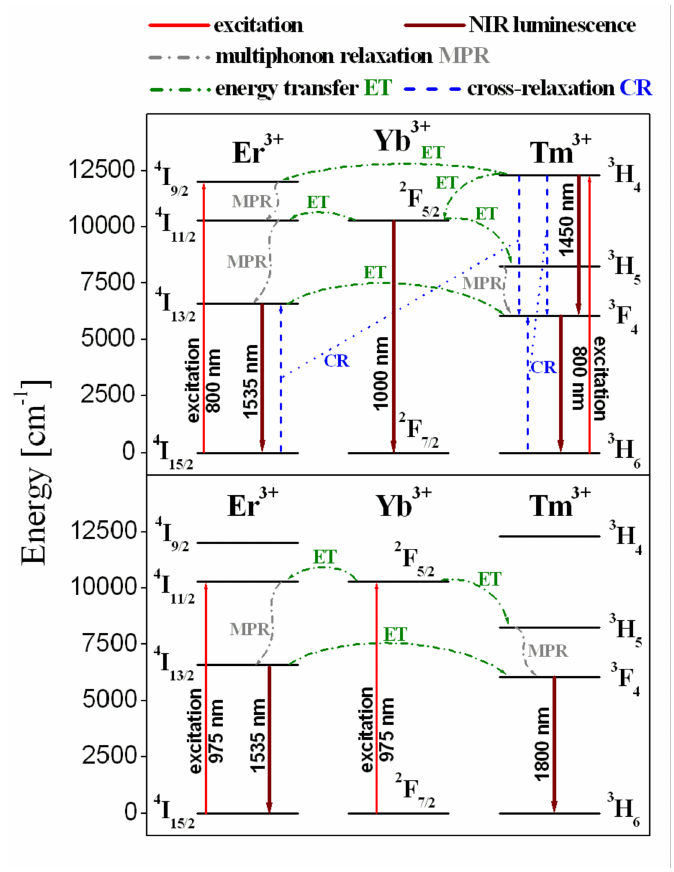
Figure 2. Energy level diagrams for lead germanate glass triply doped with Yb 3+ /Er 3+ /Tm 3+ ions excited at 800 nm ( top ) and 975 nm ( bottom ). All transitions and processes are also